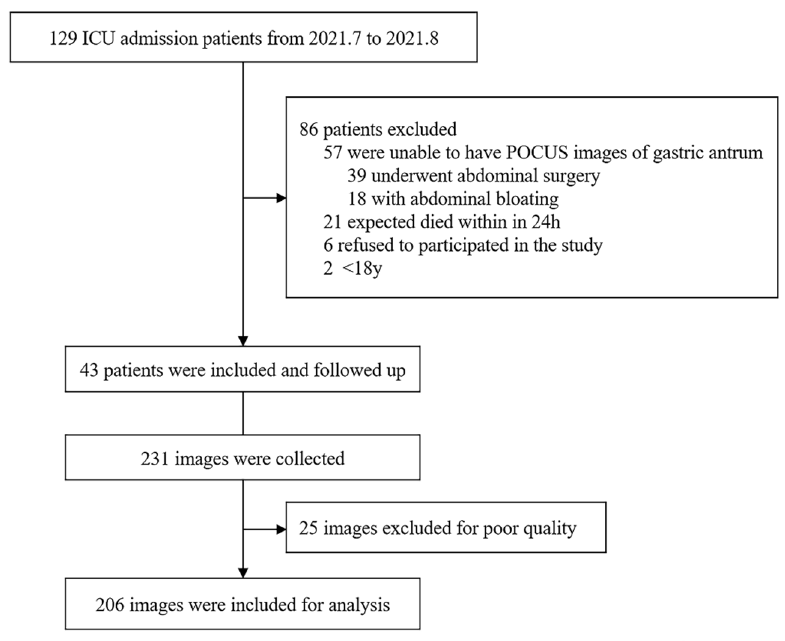
Figure 1. Flowchart and enrollment of patients. ICU: intensive care unit; POCUS: point-of-care ultrasound.